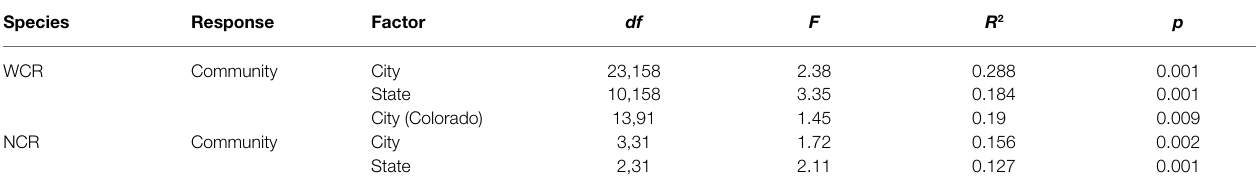
TABLE 2 | Beta diversity metric comparisons between collection site within host species.